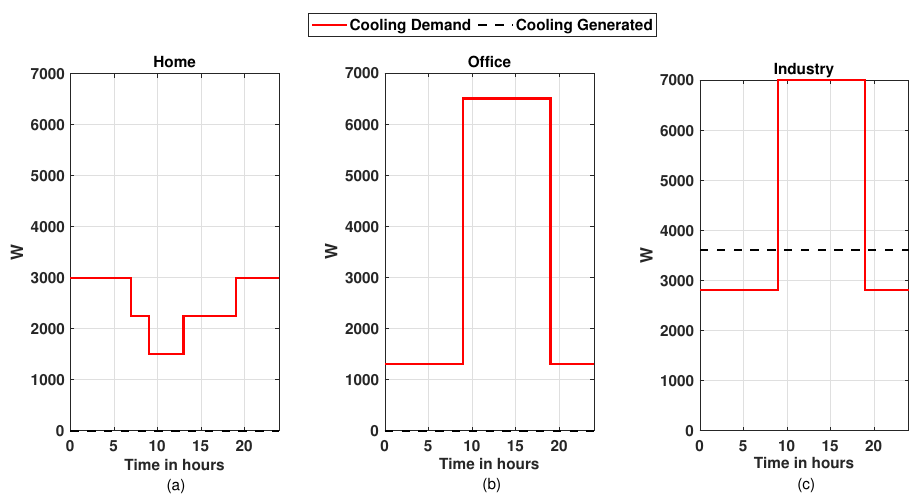
Figure 10. Cooling demand and generation of 24 h for the month of June, ( a ) for the home building, ( b ) for office building, and ( c ) for industry building.